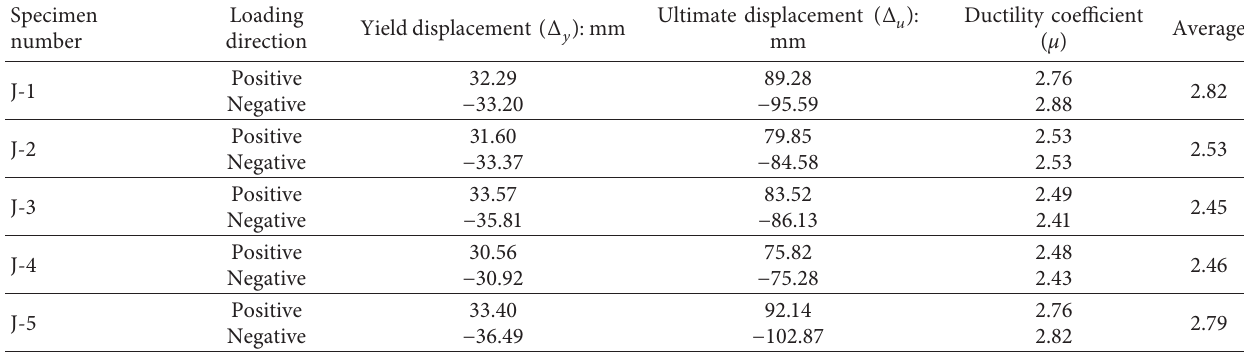
Figure 10: Determination of yielding strength. Table 6: Displacement ductility coefficient.